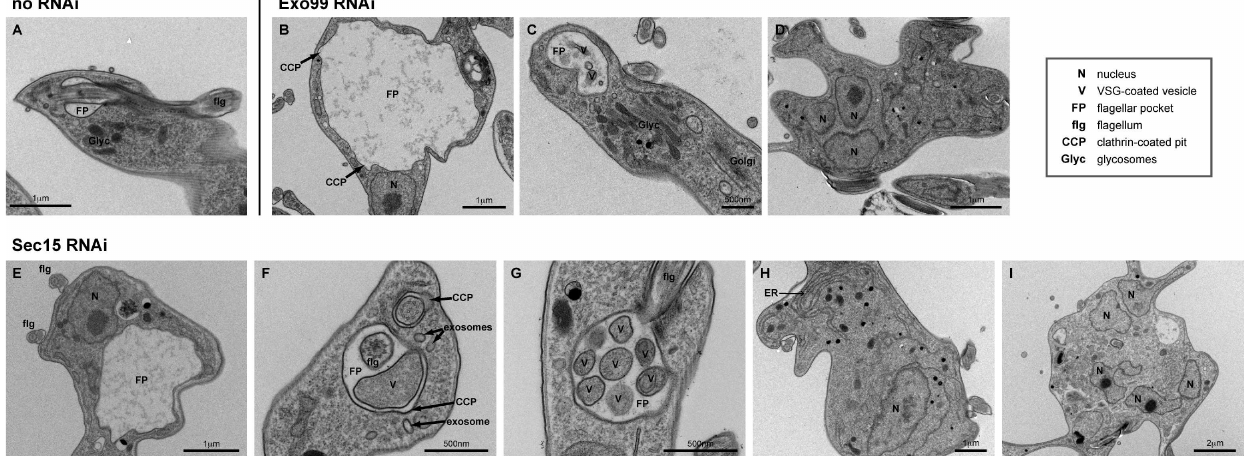
Fig 4. The exocyst is required for normal membrane trafficking. Representative transmission electron micrographs showingthe effect of exocist subunitablation48h post-RNAi inductionin BSF cells. The steady-state flagellar pocket has a small overall volume (A); ablationof Exo99 and Sec15 causes pocket enlargement (B, E), over-production of large VSG-coated vesicles inside the flagellar pocket (C, F, G), failure in cytokinesis(as illustratedby multiple nucleiin panels D and I) and ER hypertrophy (H). Despite large flagellarpocket volumes, indicativeof endocytosisdefect, clathrinis recruited to the surface membraneand able to assembleinto coated pits and lattices (B, F).